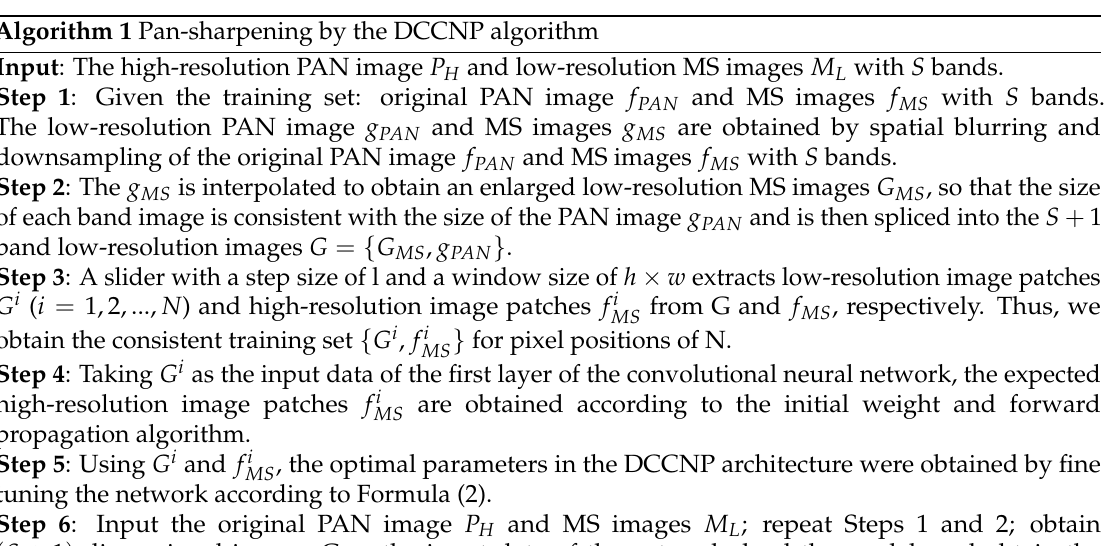
Algorithm 1 Pan-sharpening by the DCCNP